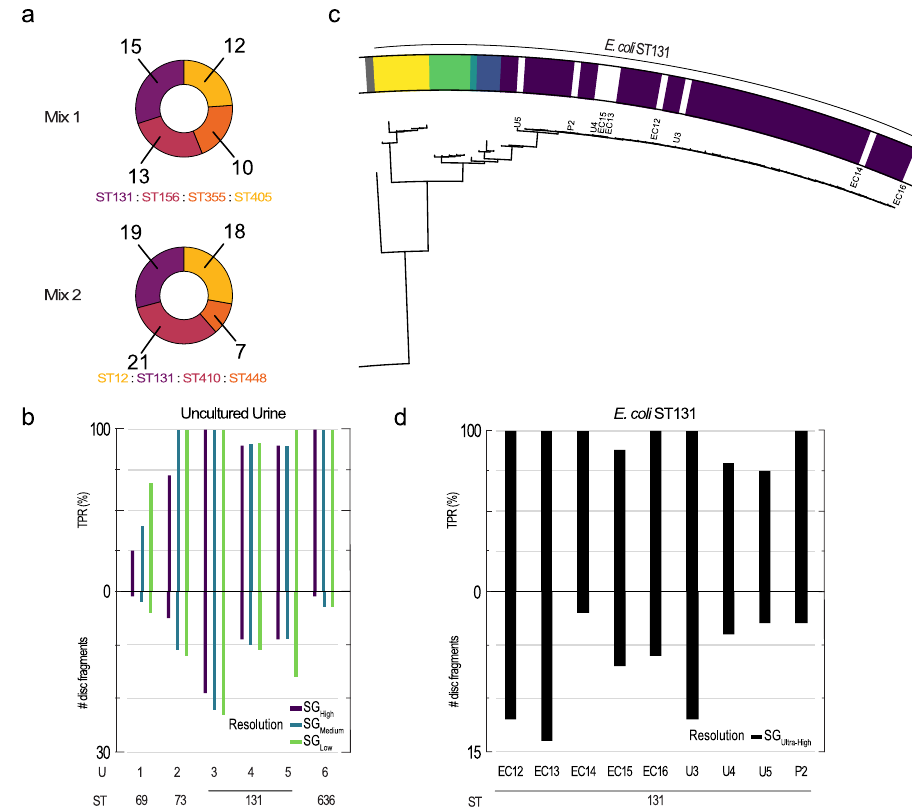
Fig. 3 Typing results for mixes, urine samples, and ST131 samples with ultra-high resolution. a The distribution of discriminative strain group (SG) matches at SG Medium -resolution for the two mixed samples, each containing four different E. coli strains in equal proportions. The number of pro fi les matching discriminatively to each identi fi ed SG is indicated next to the chart. b The number of discriminative intensity pro fi les and true positive rate (TPR) for six non-cultivated urine samples at the three investigated strain-level taxonomic resolutions, SG High , SG Medium and SG Low . c The ST131 branch of the phylogenetic tree (full tree in Supplementary Fig. 1) includes the nine ST131 samples (white) and the closest non-ST131 genome (far left in grey). The fi ve SGs for this ultra-high resolution are marked (yellow-purple). d The number of discriminative intensity pro fi les and true positive rate (TPR) for the nine ST131 samples plotted at ultra-high resolution (SG Ultra-High ), corresponding to the fi ve SGs of the ST131